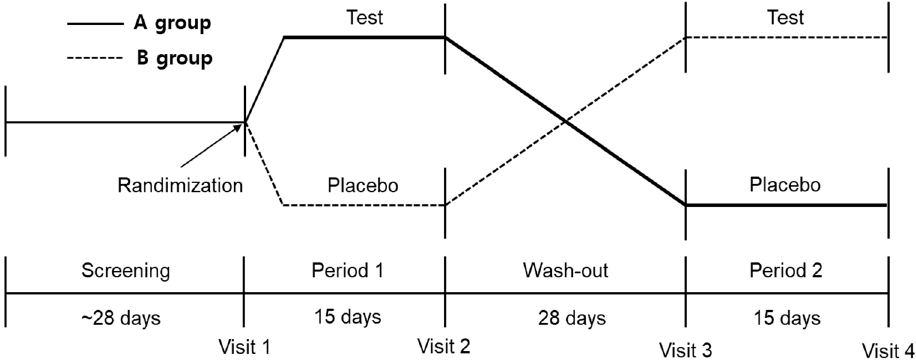
Figure 1. Scheme of the crossover design protocol.